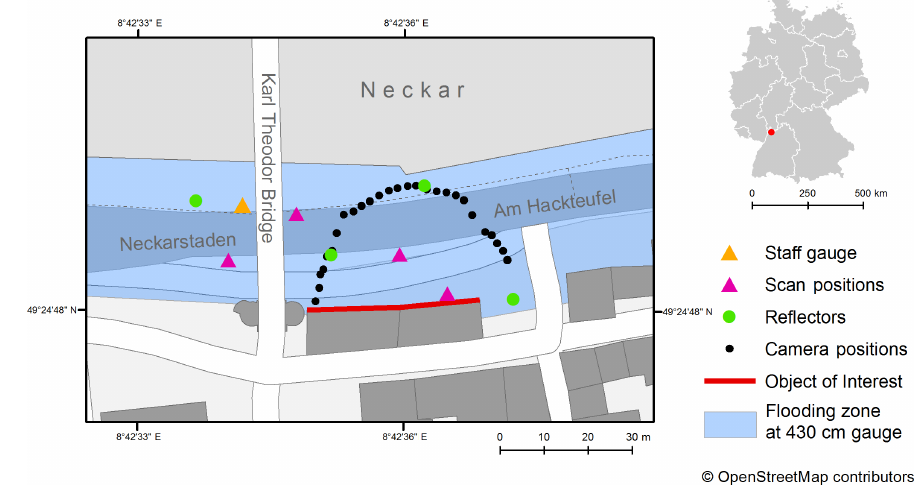
Figure 1. Overview map of the study area, including the measurement setup for acquisition of the terrestrial laser scanning (TLS) data and the camera positions of the non-flood